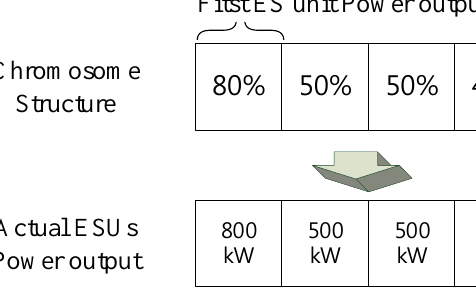
Figure 7. Genetic algorithm flowchart for lookup table generation.